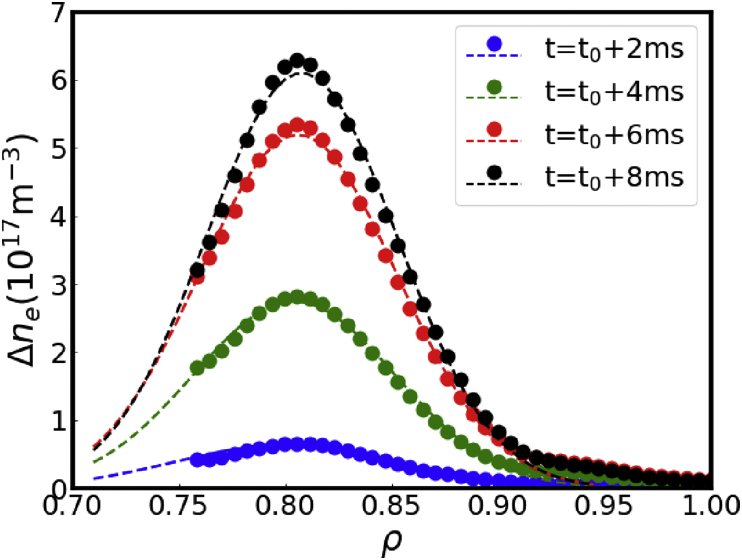
Temporal evolution of density perturbation in the early phase of SMBI.